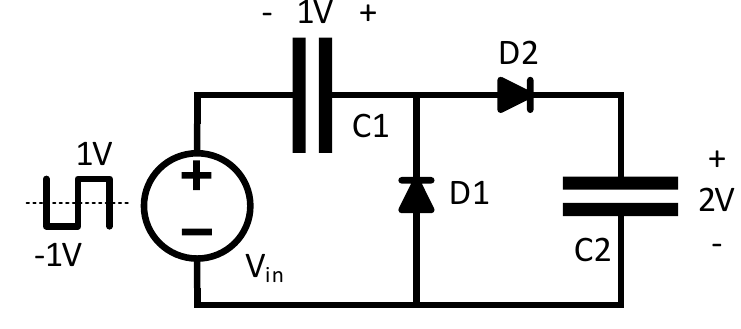
Figure 7. Two-stage Dickson charge pump. In phase 1, V in = − 1 V charges C1 to 1 V through D1. In phase 2, V in = 1 V stacks with C1 to charge C2 to 2